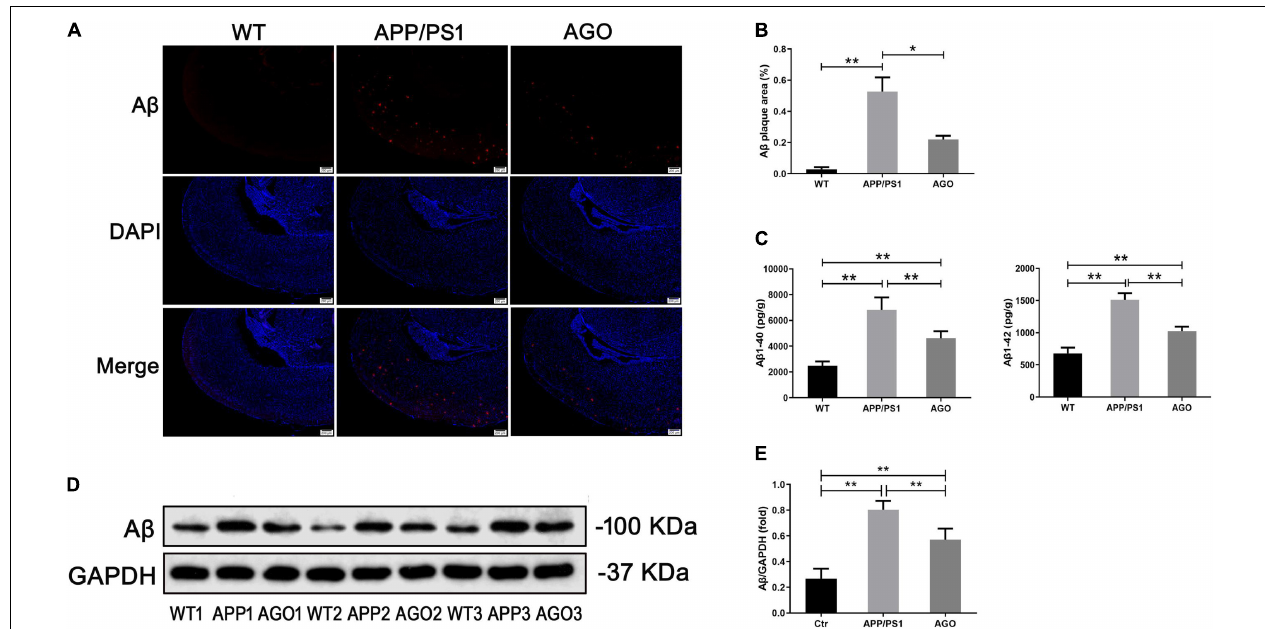
FIGURE 2 | Effects of agomelatine on A β deposition in APP/PS1 mice. In the agomelatine-treated group, mice were intraperitoneally injected with agomelatine (50 mg/kg/day) for 30 days. (A,B) Measurement of A β expression by immunofluorescence (40 × , scale bars = 200 µ m) ( n = 3). (C) Measurement of A β content by ELISA ( n = 5). (D,E) Measurement of A β expression by Western blot ( n = 5). Values are represented as the mean ± SEM. * P < 0.05; ** P < 0.01.